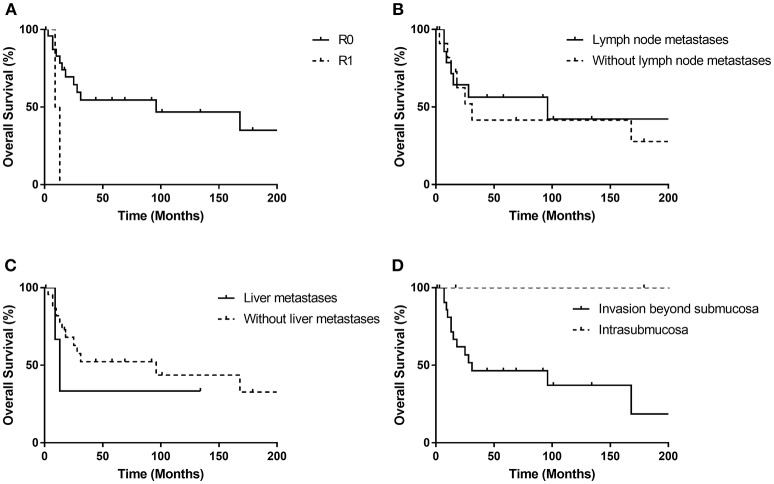
Kaplan-Meier curves for the overall survival stratified by possible prognostic factors (A–D). R0 resection was related with longer OS (p = 0.021), while lymph node metastasis (p = 0.733), liver metastasis (p = 0.505) and invasion beyond submucosa (p = 0.076) did not show statistically significant correlations.